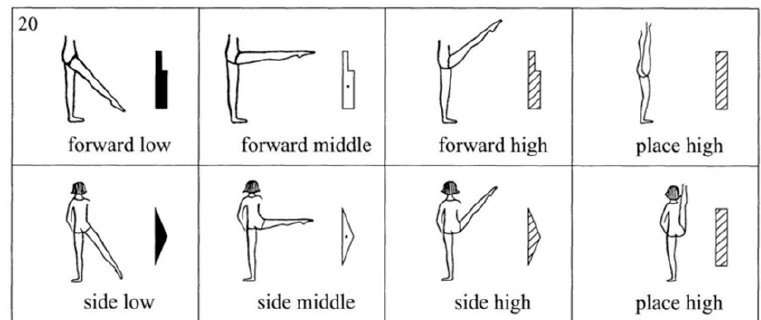
Figure 7. Levels for leg gestures in Kinetography. Created by Ann Hutchinson Guest, used with permission from the author.